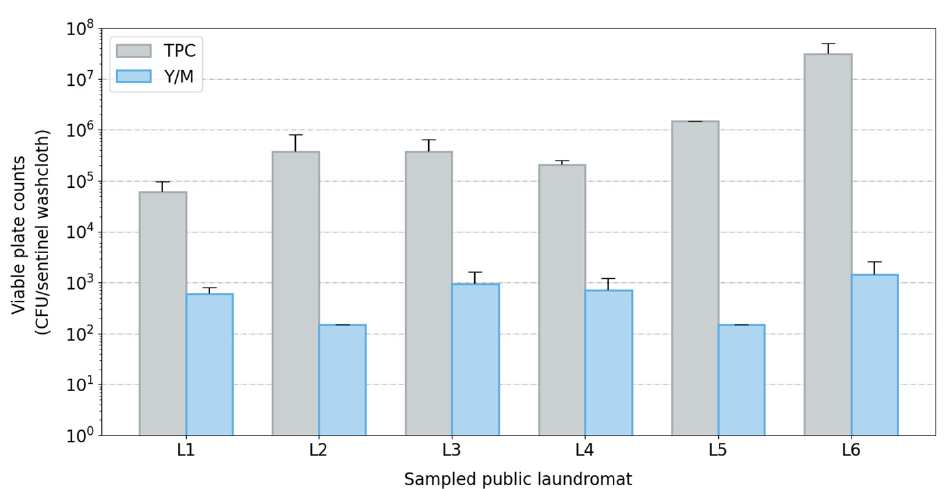
Figure 2. Bar plot of viable plate counts across sampled laundromats (L1–L6). Viable plate counts (bacterial and fungal) from extracted sentinel washcloths (one per washing machine) post-laundering using a cold-water cycle in public washing machines. Abbreviations used: CFU, colony-forming units; TPC, total plate counts; Y/M, yeast and mold counts.